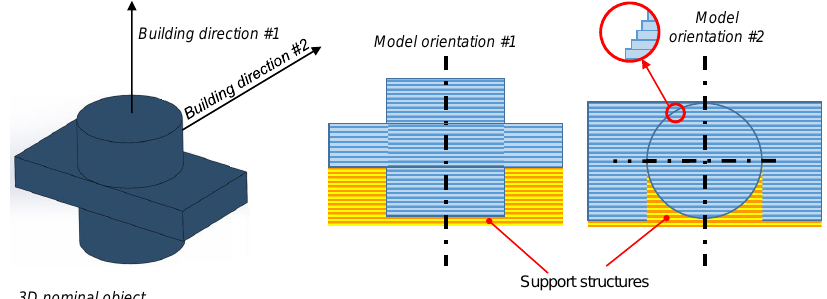
Fig. 4 Profile contour processing